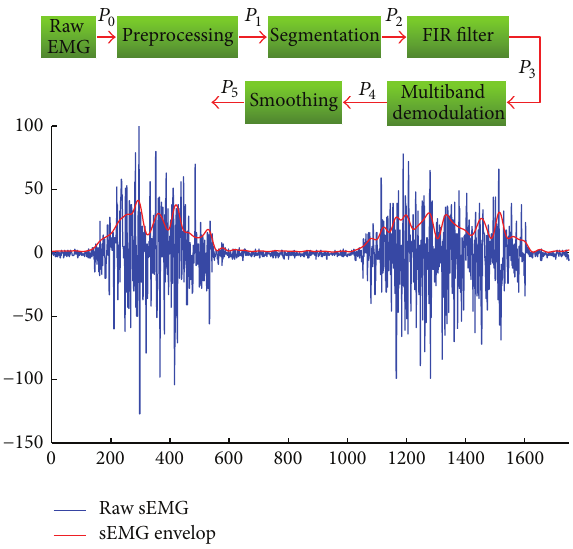
Figure 5: Procedure and example of sEMG enveloping based on multiband AM-FM model. 𝑃 𝑚 is the output of every processing module.